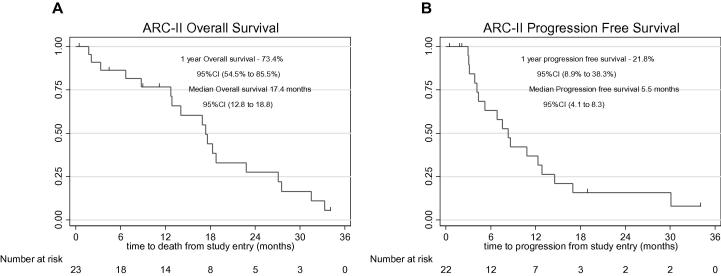
Clinical outcome in patients treated within the ARC-II clinical trial. Kaplan–Meier estimates of (A) Overall survival and (B) progression-free survival.